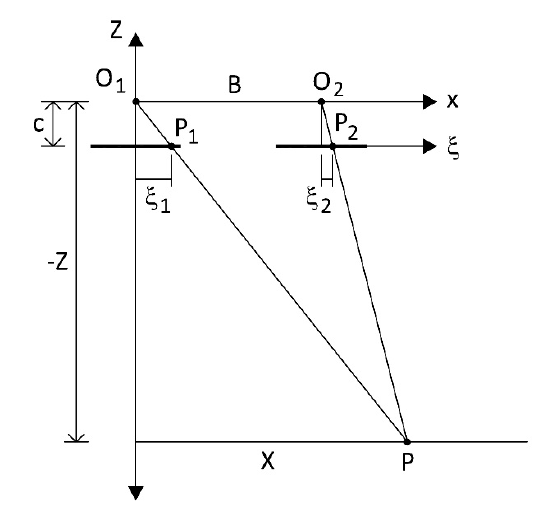
Figure 1. Kraus standard deviation evaluations The Kraus formula represents the standard deviation only along the Z axis, because is generally the most significant